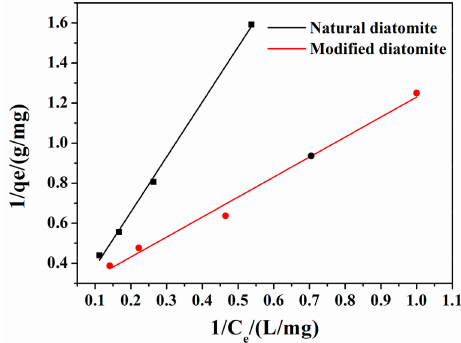
Figure 8. Diatomite adsorption 1-naphthol of Langmuir isotherm plots. Black: raw diatomite; Red: calcined 450 ◦ C